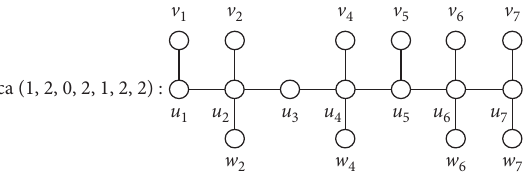
Figure 2: The caterpillar ca ( 1 , 2 , 0 , 2 , 1 , 2 , 2 ) with Ψ � 2 , 4 , 6 , 7 { } .